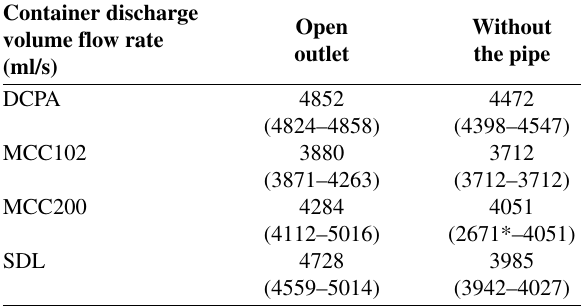
Table 5. Container discharge volume flow rates in open outlet con- dition, and the condition without the pipe for all tested materials: dicalcium phosphate anhydrous (DCPA), microcrystalline cellulo- se MCC102 and MCC200, and spray-dried lactose (SDL). The me- dian value is presented with minimum and maximum values listed in